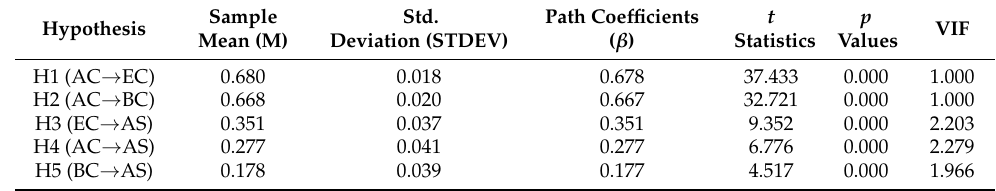
Table 2. Significance testing results of the structural model path